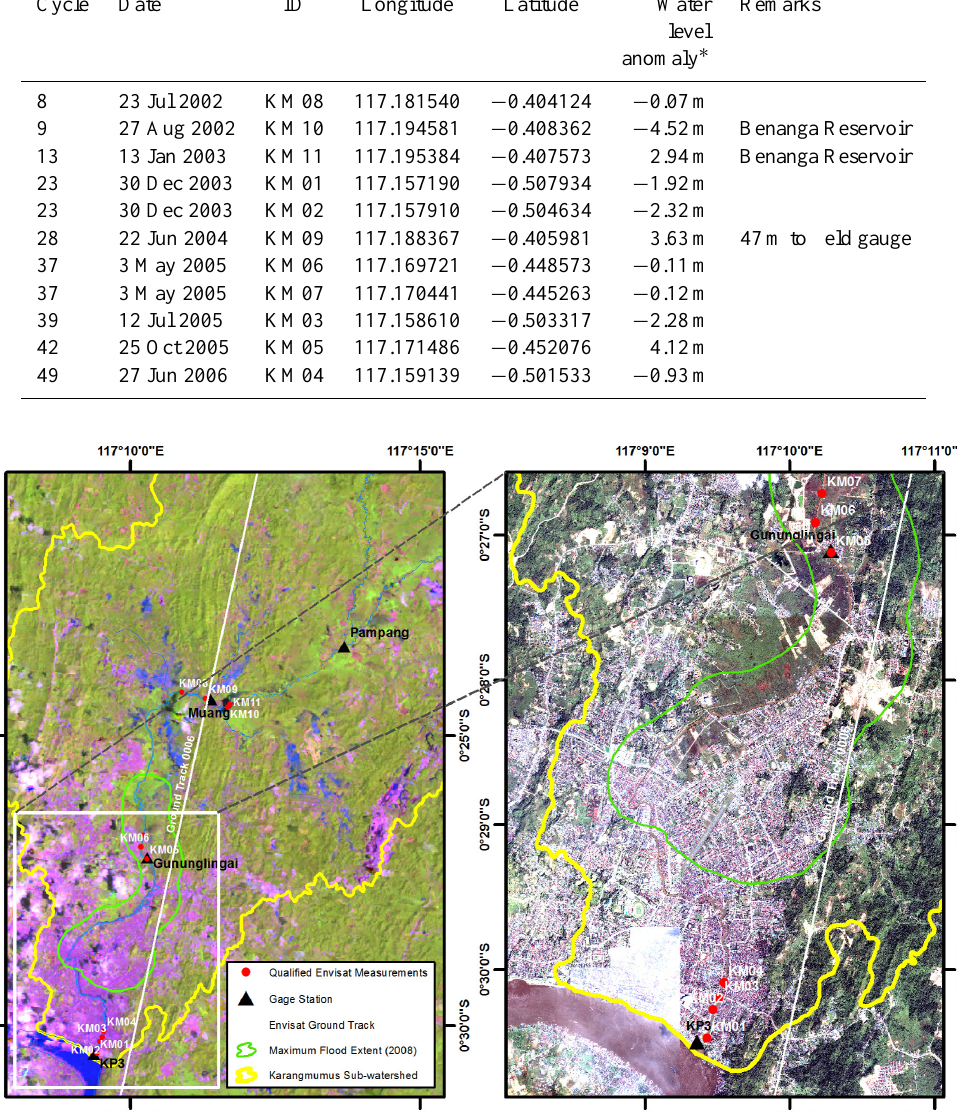
Figure 10. The Karangmumus sub-watershed. Left panel: overview of the sub-watershed with Landsat-7 image of January 2007 as the background. Right panel: detailed view of the urbanized downstream part with IKONOS image of February 2002 as the background. Envisat ground tracks appear as white lines in both